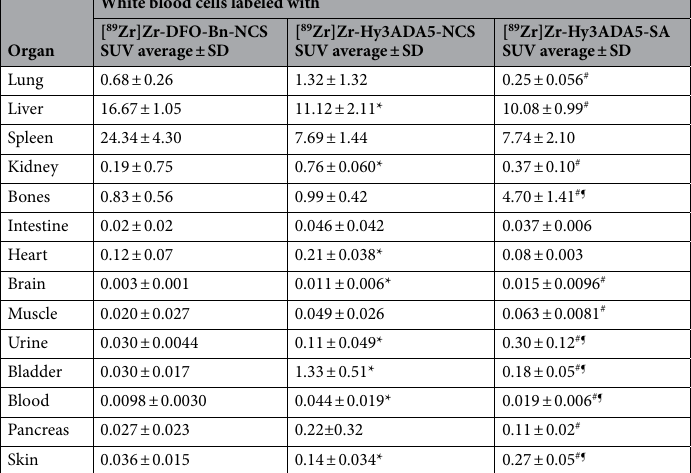
Table 2. Uptake (SUV) and biodistribution of white blood cells (WBCs) labeled with [ 89 Zr]Zr-DFO-NCS (n = 4), [ 89 Zr]Zr-Hy 3 ADA 5 -NCS (n = 4) and [ 89 Zr]Zr-Hy 3 ADA 5 -SA (n = 4) synthons in athymic nude mice at day 7 post-injection. *p < 0.05 WBCs labeled with [ 89 Zr]Zr-DFO-Bn-NCS Vs [ 89 Zr]Zr-Hy 3 ADA 5 -NCS. # p < 0.05 WBCs labeled with [ 89 Zr]Zr-DFO-Bn-NCS Vs [ 89 Zr]Zr-Hy 5 -SA. ¶ p < 0.05 WBCs labeled 3 ADA